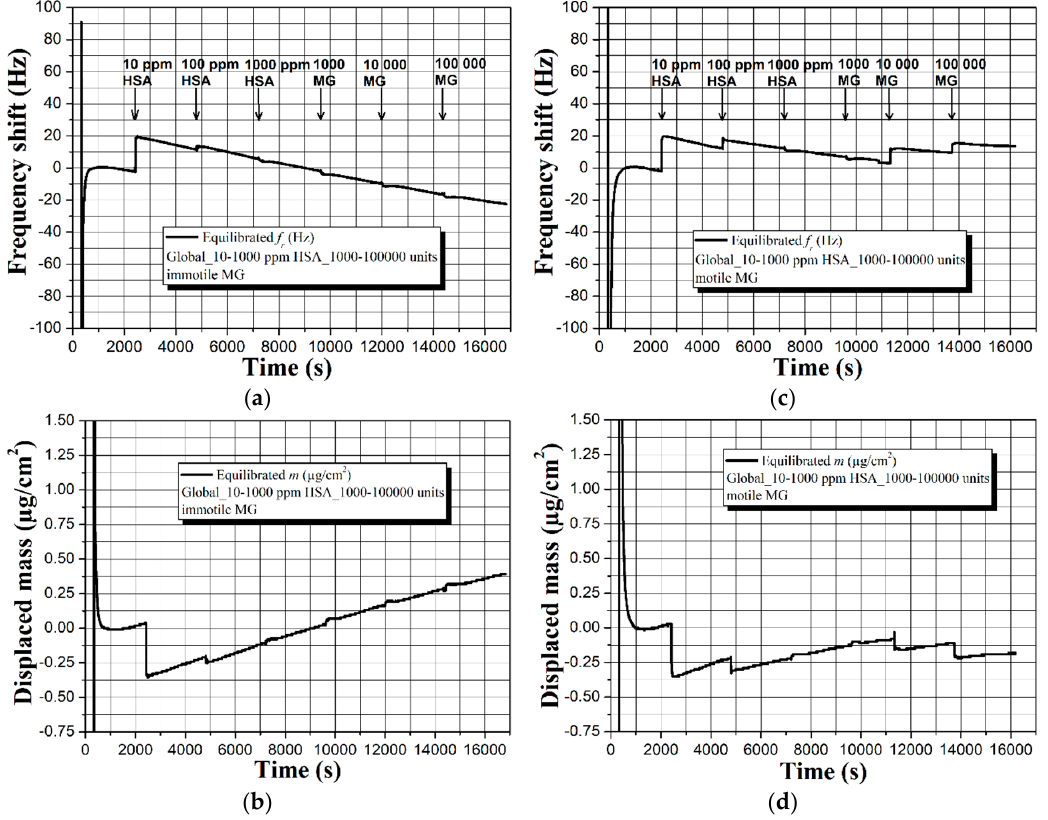
Figure 6. Real-time sensor response of a soot coated 5 MHz QCM to ( a , b ) HSA and immotile and ( c , d ) HSA and progressively motile human spermatozoa with gradually increasing concentration. All graphs reflect actual biomass effects after equilibration of the baselines in Global medium .